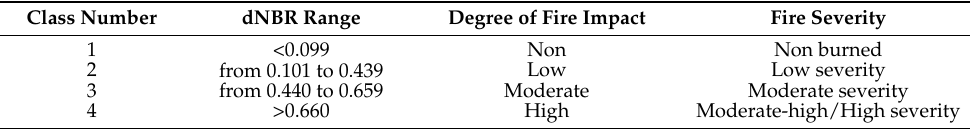
Table 1. Classification of fire impact based on the ranges of the dNBR index. Class